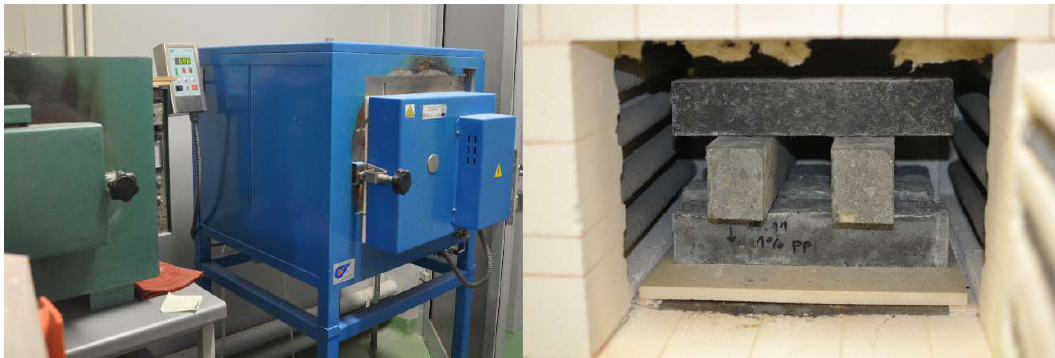
Figure 2. Specimens in oven chamber.